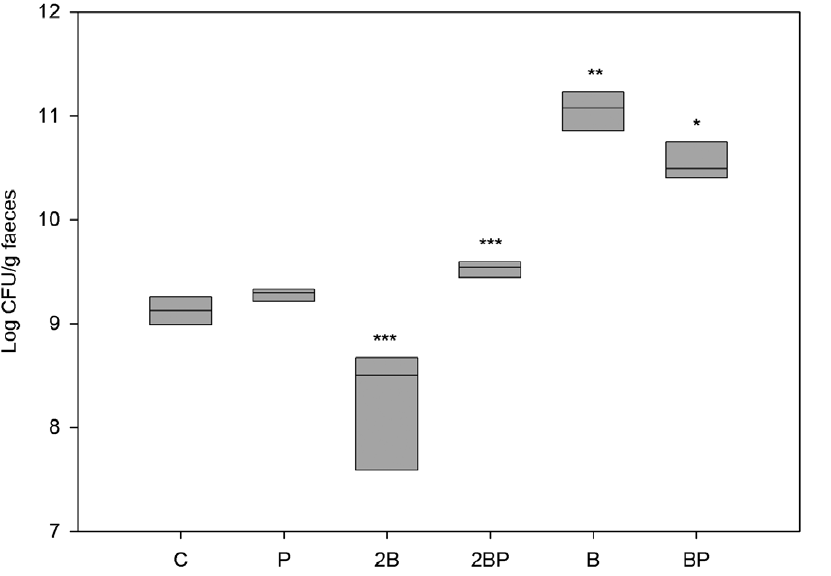
Figure 12. Faecal load of lactobacilli. Viable count of lactobacilli (log CFU/g faecal sample)*P , 0.05, **P , 0.01, ***P # 0.001 compared to group C. A decrease was found in group 2B *** P # 0.001 compared to group C. By the addition of probiotics: 2B group vs 2BP group ***P # 0.001, and B vs BP group *P , 0.05.